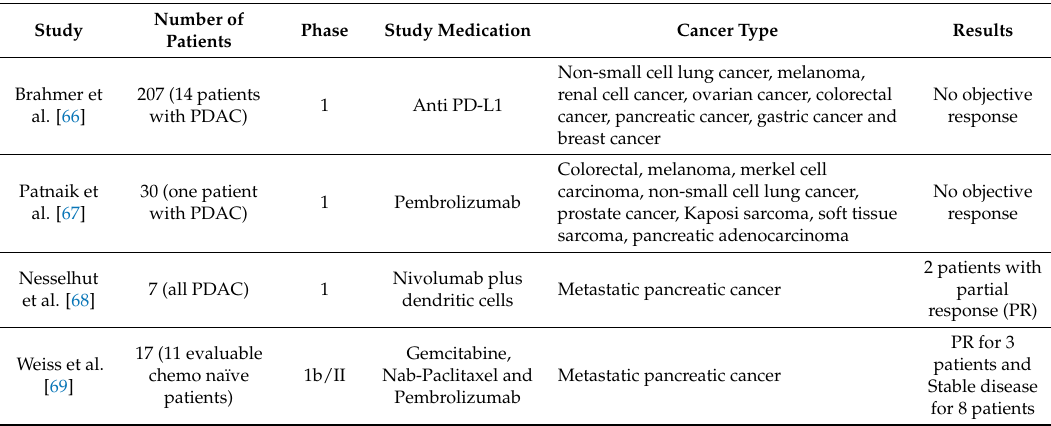
Table 2. Completed Clinical trials of the PD-1/PD-L1 blockade in PDAC.